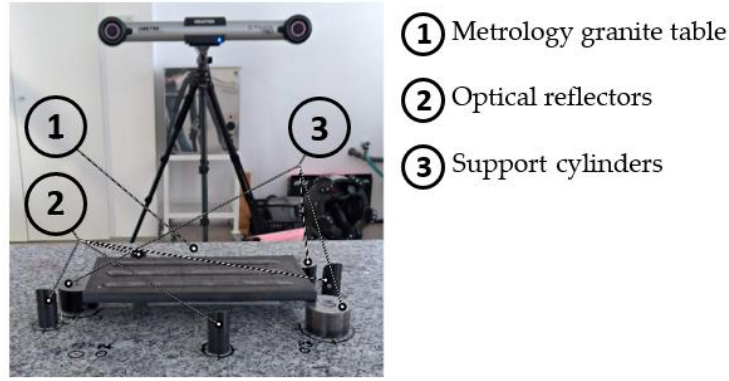
Figure 4. Experimental set-up for measuring distortions of specimens.